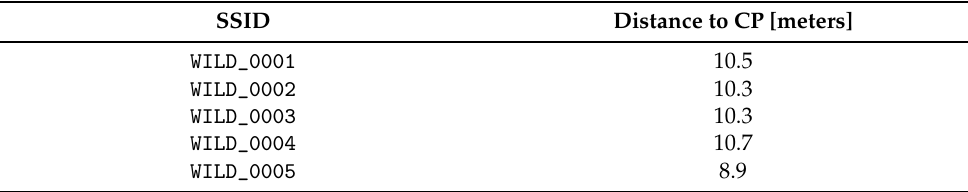
Table 2. Geometric distances between the setup Central Point (CP) and each of the routers considered in the data